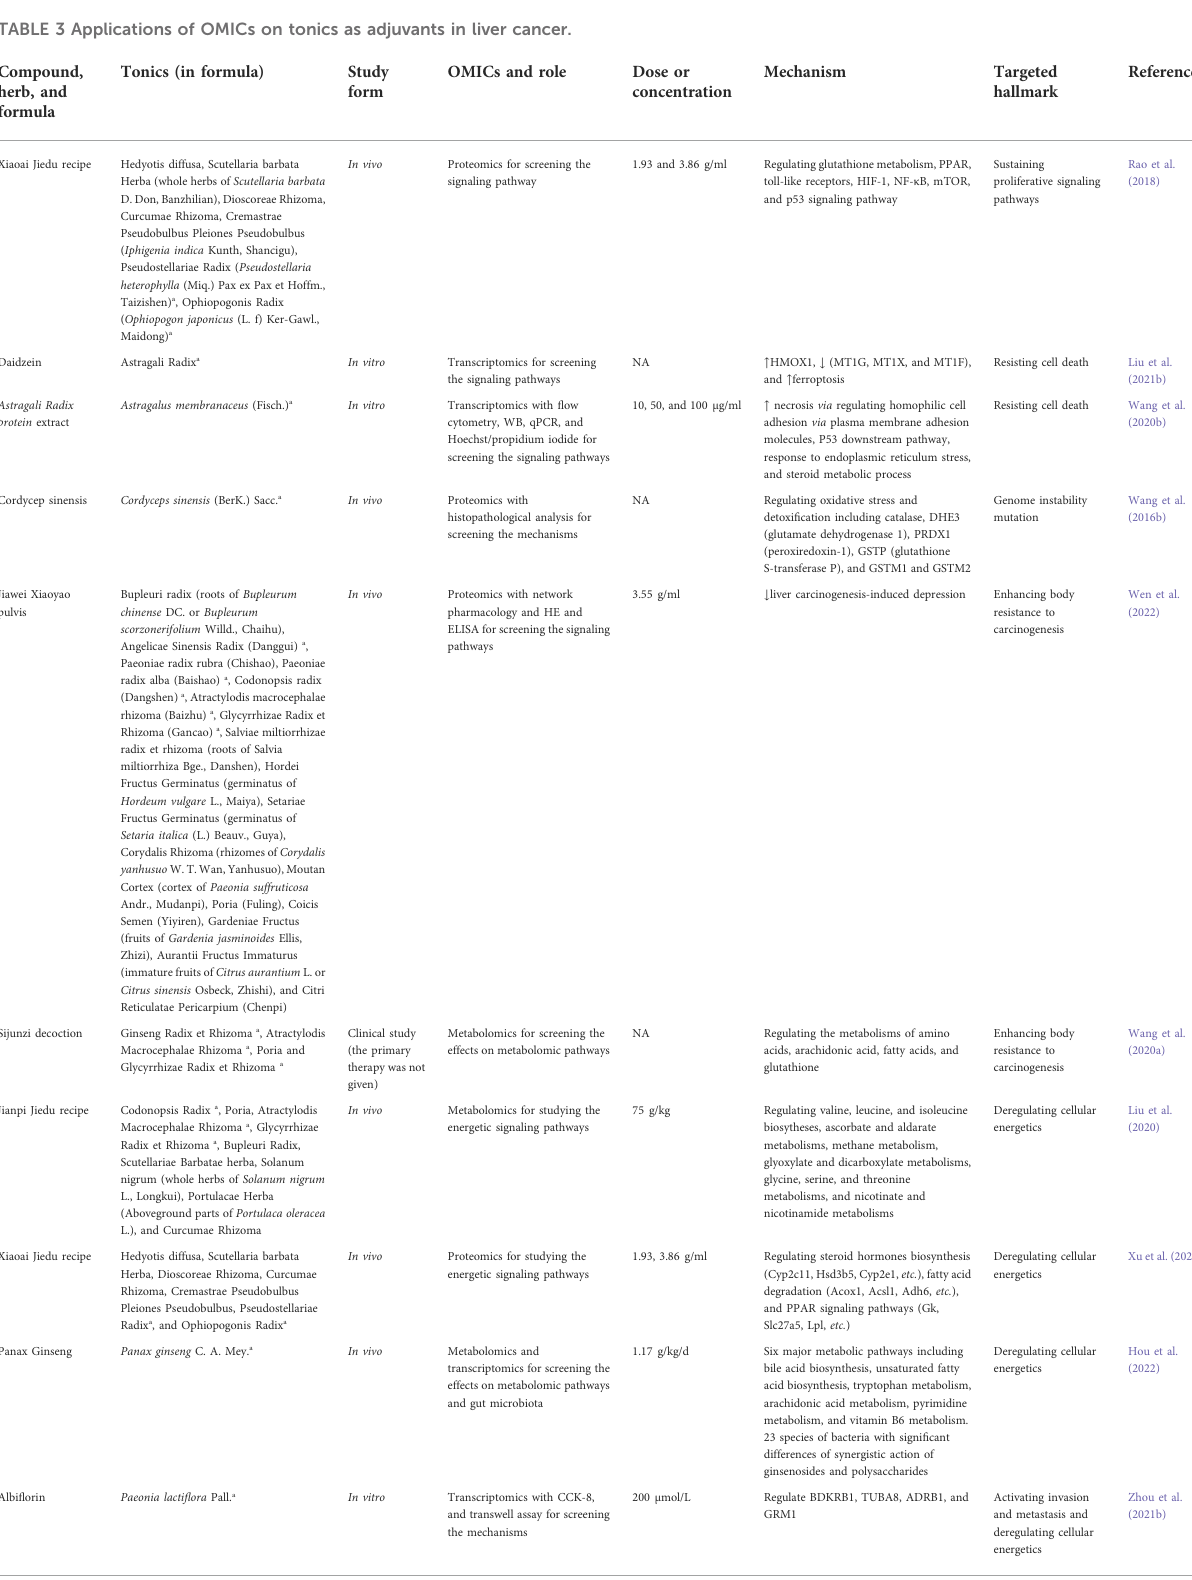
TABLE 3 Applications of OMICs on tonics as adjuvants in liver cancer. Compound, herb,